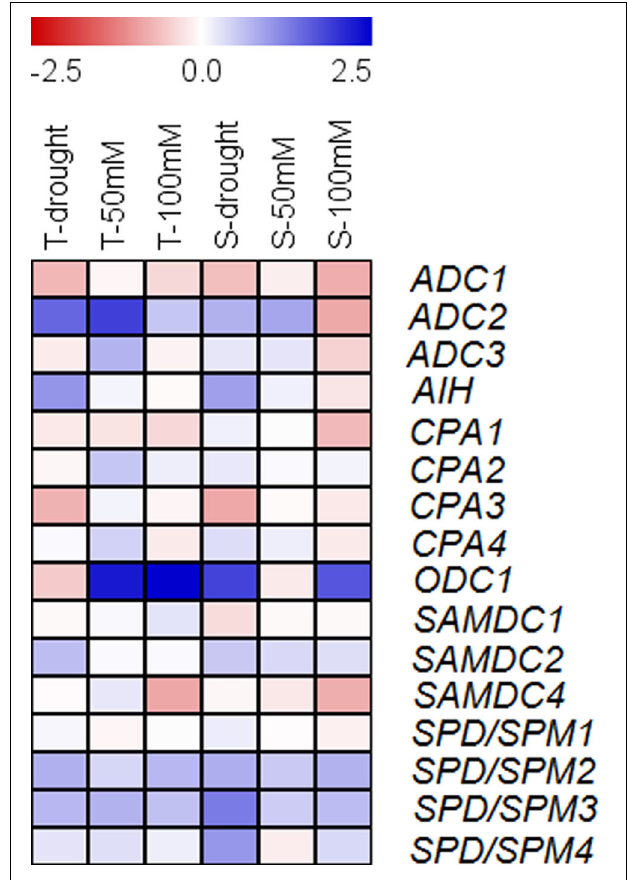
FIGURE 8 | Log 2 fold change of expression of genes, encoding enzymes involved in polyamine biosynthesis, under drought and salt conditions as compared to control in three tolerant vs. sensitive cultivars of the respective stress condition. Log 2 fold change of gene expression is shown for drought- and salt-tolerant (T) (52, 4, 1) and drought- (22, 2, 50) and salt-sensitive cultivars (S) (22, 2, 50). Data represent the means of three cultivars from either one or two biological replicates with two technical replicates